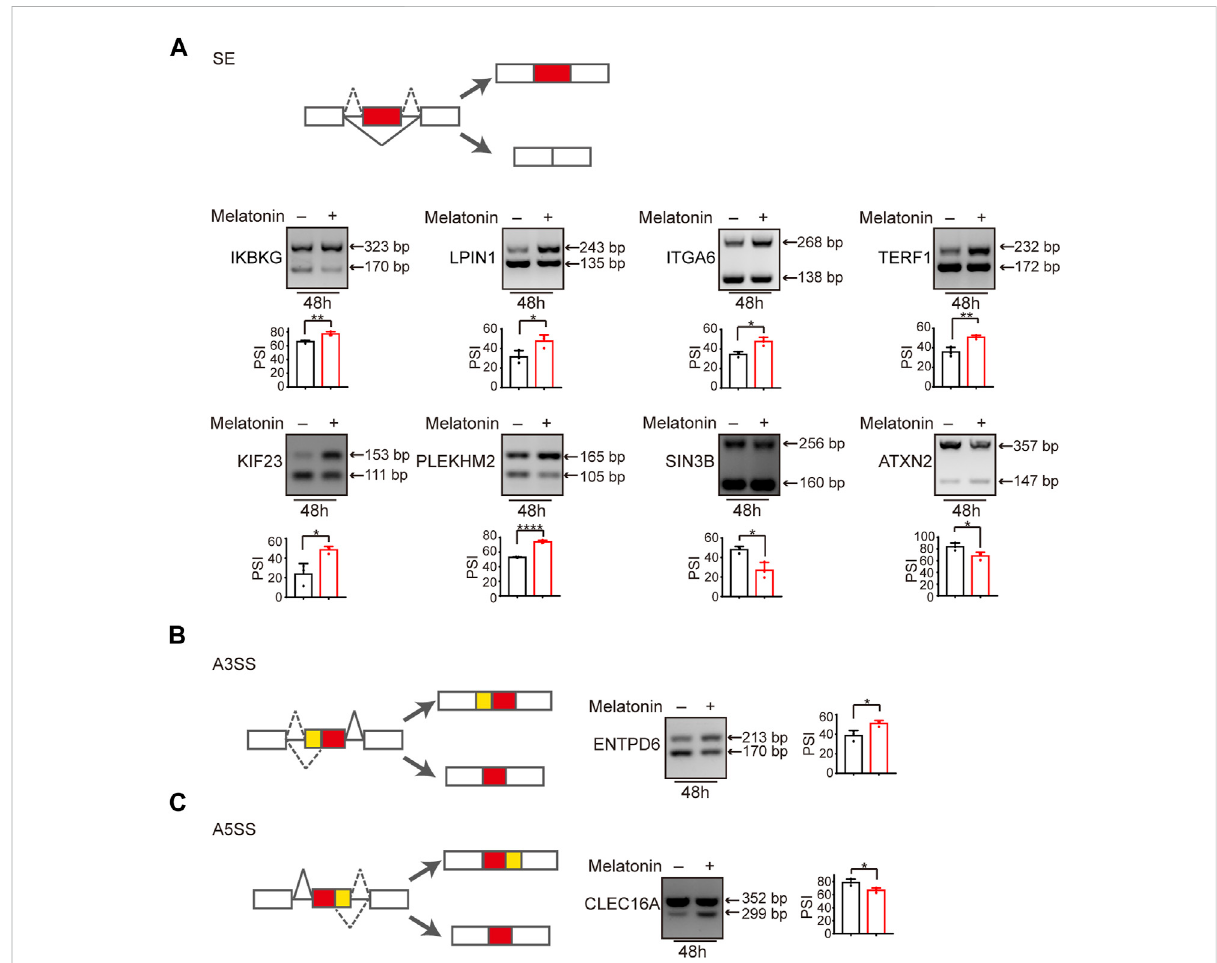
FIGURE 4 Alternative splicing switch induced by melatonin. (A) Exons skipping in IKBKG , LPIN1 , ITGA6 , TERF1 , KIF23 , PLEKHM2 , SIN3B , and ATXN2 were examined by semi-quantitative RT-PCR in HepG2 cells treated with 1 mM melatonin for 48 h. The mean ± SD of PSIs from three experiments were plotted and p values calculated by unpaired t test. (B,C) Alternative 3 ′ splice sites usage of ENTPD6 and alternative 5 ′ splice sites usage of CLEC16A were examined by semi-quantitative RT-PCR in HepG2 cells treated with 1 mM melatonin for 48 h. The mean ± SD of PSIs from three experiments were plotted and p values calculated by unpaired t